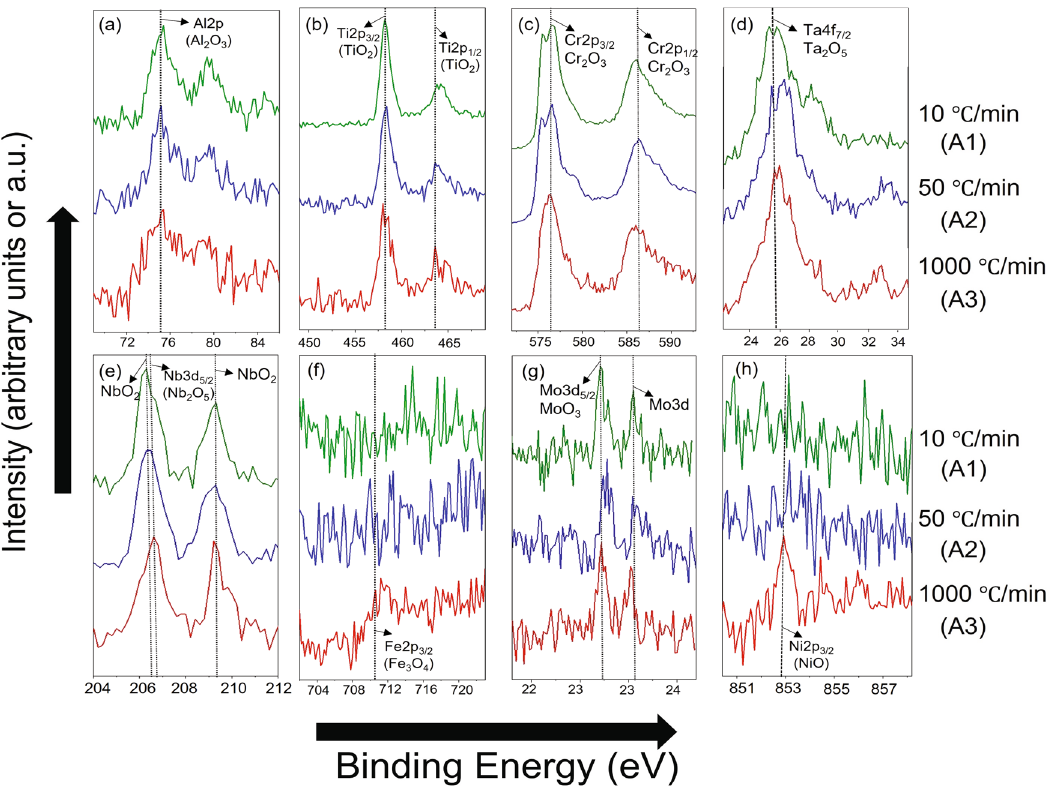
Fig. 1 XPS spectral analysis of non-isothermally treated L-DED fabricated IN718. Spectra corresponding to the component elements a Al, b Ti, c Cr, d Ta, e Nb, f Fe, g Mo, and h